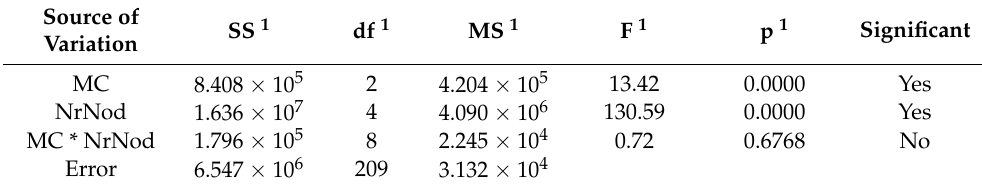
Table 7. Two-way ANOVA results for modulus of elasticity in bending (MOE bend ). Source of SS Variation